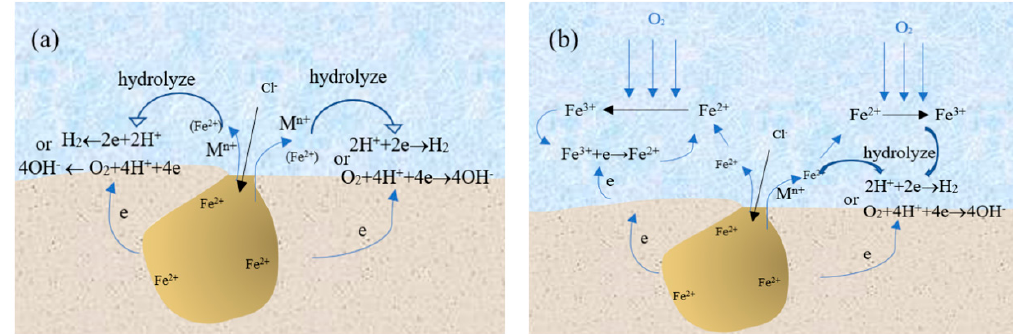
Figure 8. Pitting corrosion model for stainless steel in the environment without ( a ) and with ( b ) transformation from Fe 2+ to Fe 3+ .